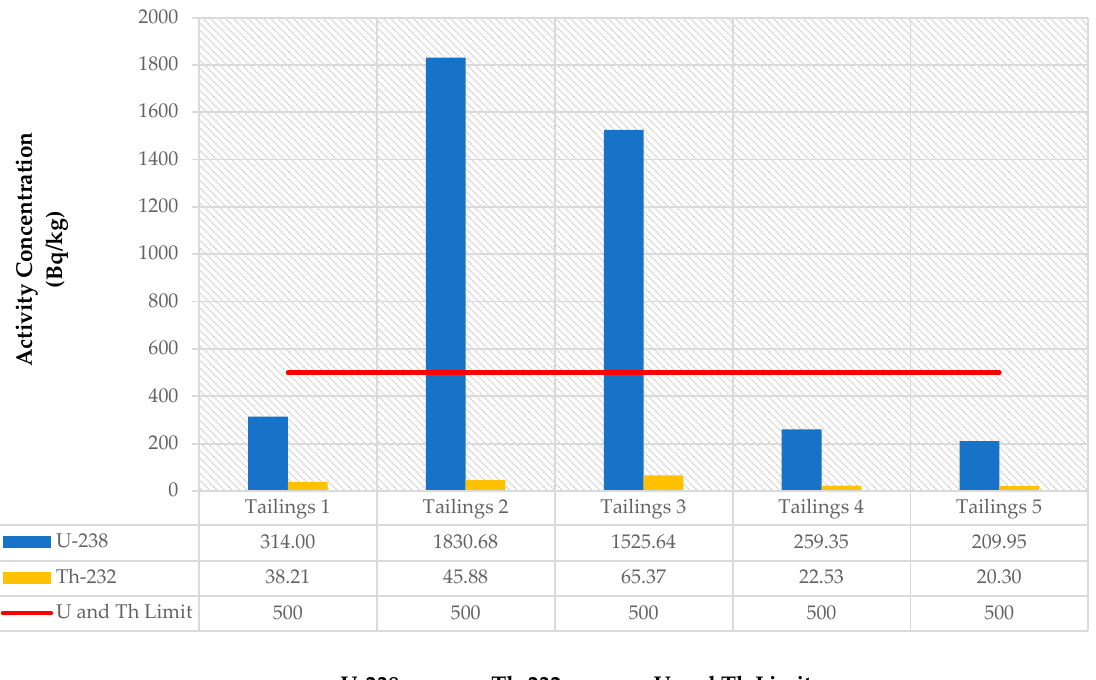
Figure 5. Comparison of the activity concentrations of 238 U and 232 Th in mine tailings with the recommended regulatory limits.